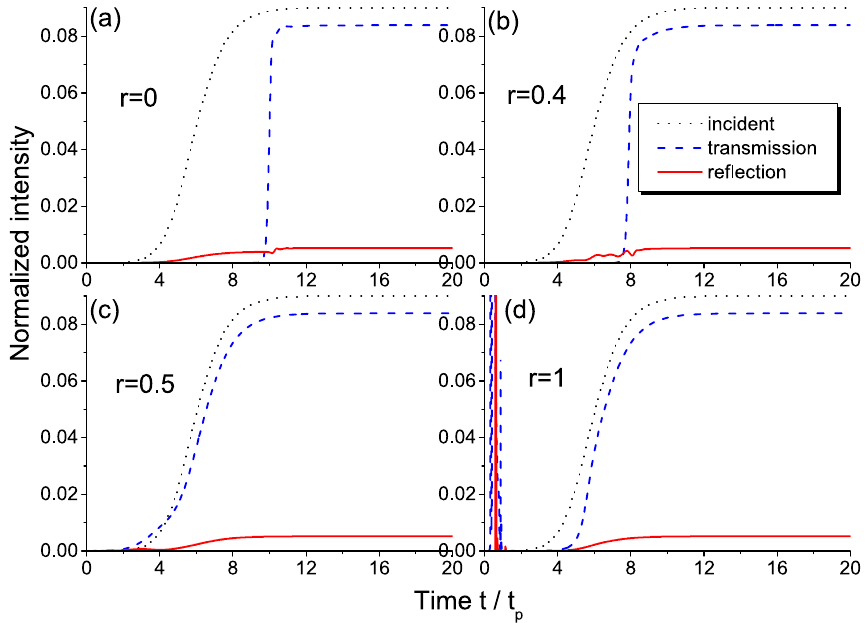
Figure 5. Intensity profiles for the transmitted and reflected light in the case of incident adiabatic front. Different panels show the results for different disorder strengths r